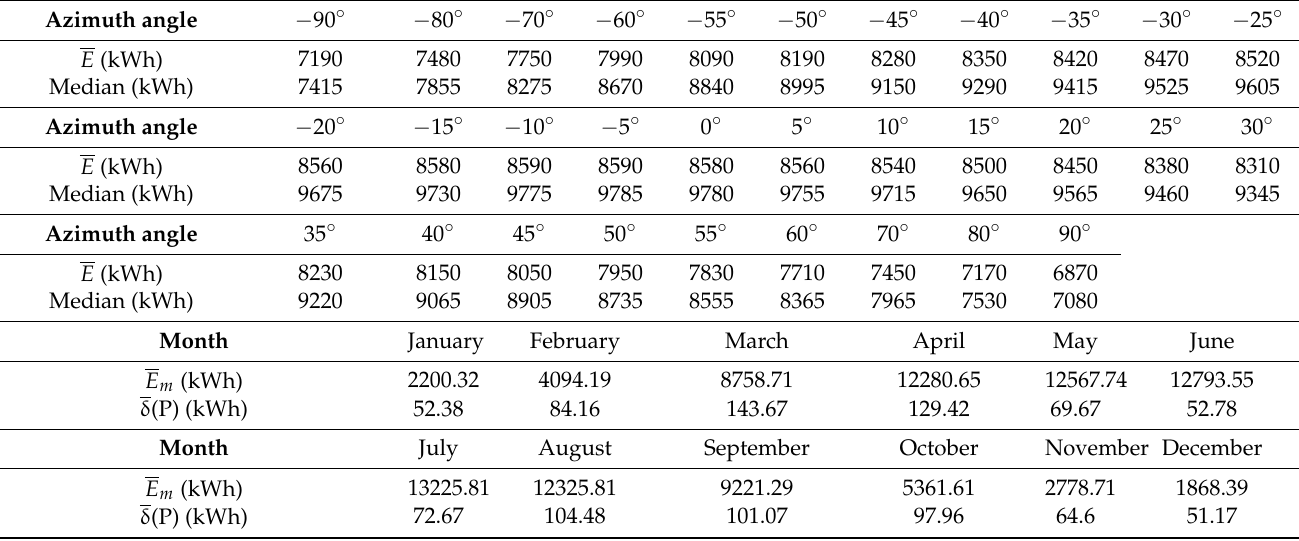
Table 2. Average amount of energy ( E ) produced by PV system with different azimuth orientation and tilt angle 35 ◦ , average energy produced per month ( E m ).